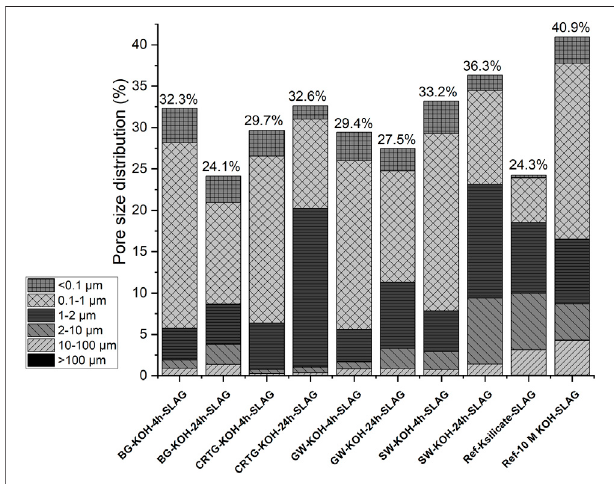
FIGURE 8 | Stacked graph showing the pore size distribution of hardened alkali-activated slag samples after curing for 72 h at 70 °